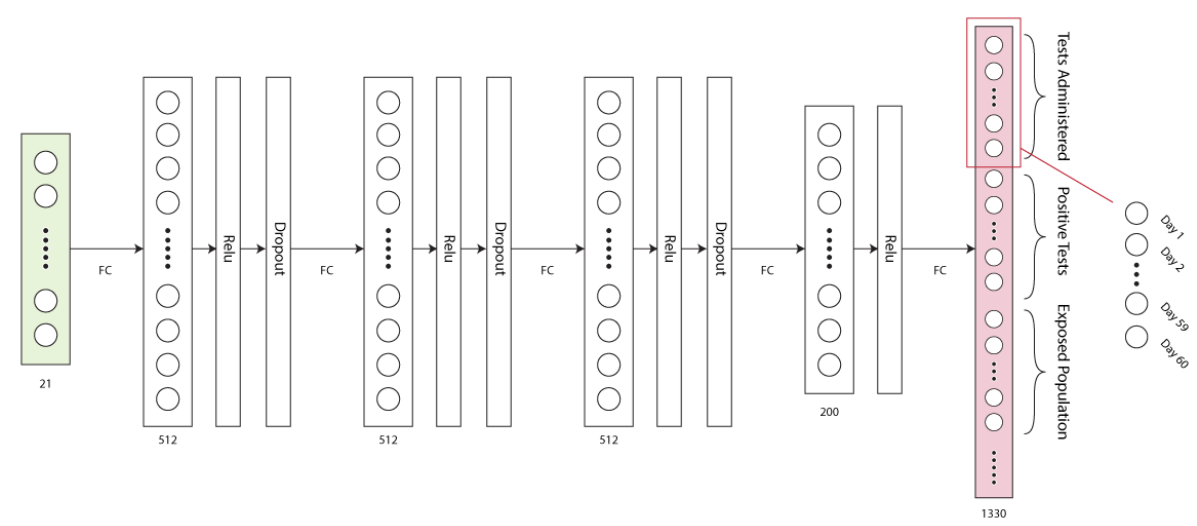
Figure 3. Final neural network design. The box colored in green contains the input parameters, followed by 3 fully con-